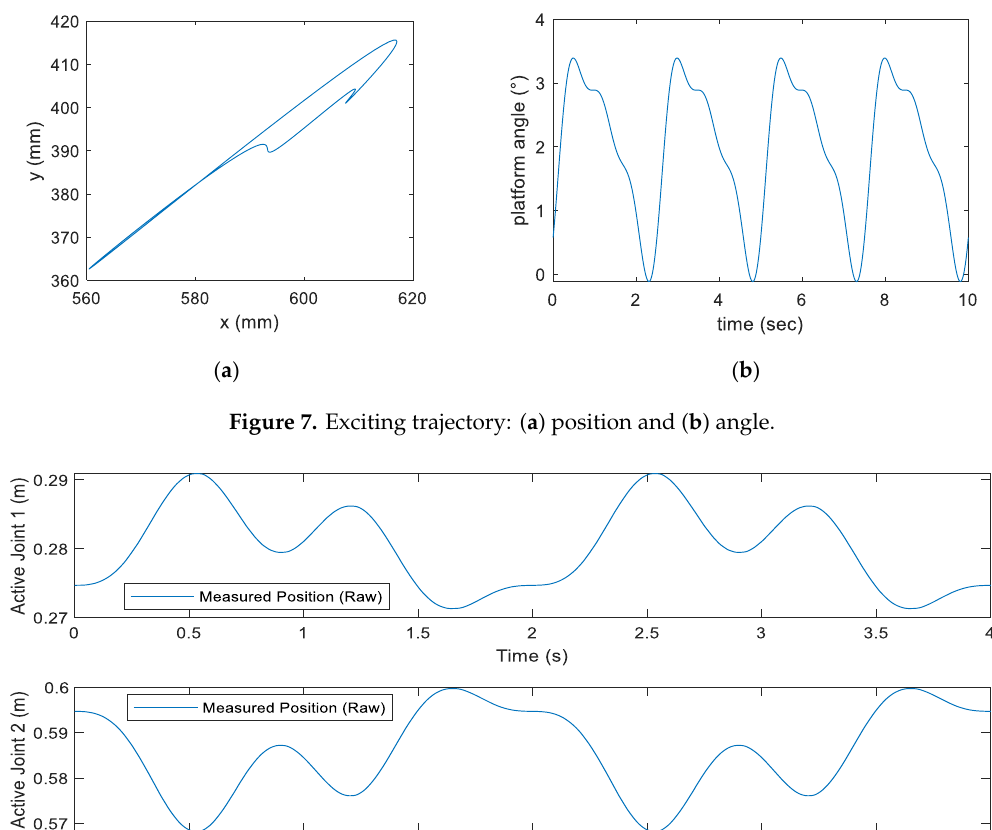
Figure 9. Raw and filtered measured active joint velocities.